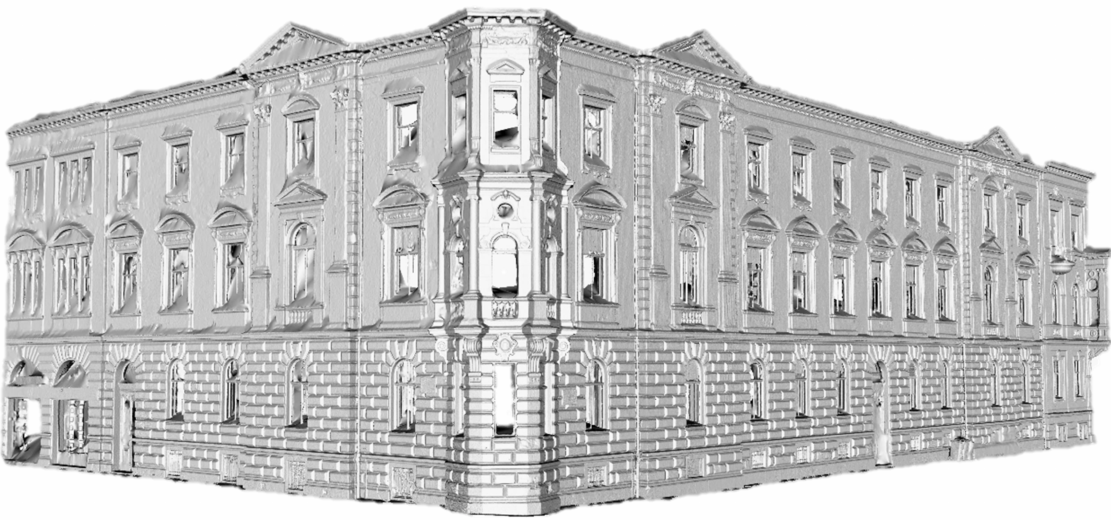
Figure 6. Laser scan of the building’s